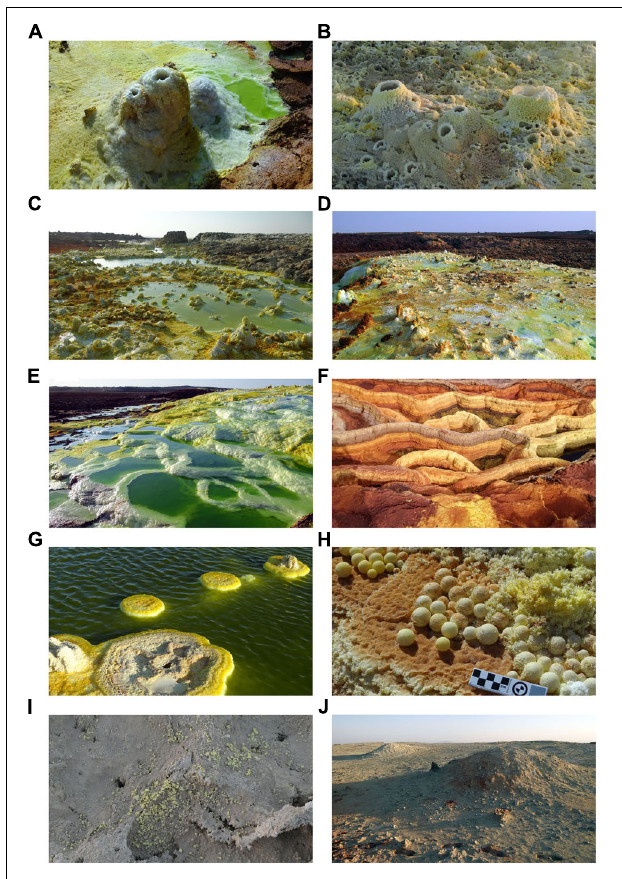
FIGURE 8 | Geothermal features of the Dallol dome. (A) Small active geyser (white colored) with associated pool and a small pillar with open vents evolving to fumaroles. (B) Fumaroles in a steam-dominated ground. (C) Small coned geysers and acidic brine pools. (D) Flat top terrace of small-coned geysers and ponds evolving to fumaroles of a steam-dominated ground. (E) Terraced pools descending in cascade on the flank of a flattop geyser ground. (F) Dried terraced pools in a steam-dominated phase. (G) Mushroom-like salt deposits growing around an effusion point inside a pool. (H) Salt balls in a terraced dry pool. (I) Sulfur deposits around degassing vents. (J) Ancient geothermal ground with remnants of degassing vents and associated native sulfur